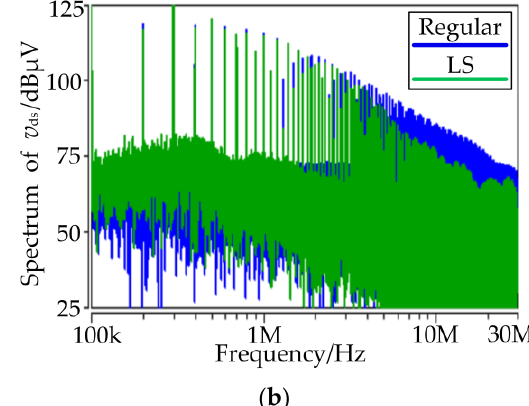
Figure 7. Chua ’ s simulation circuit.